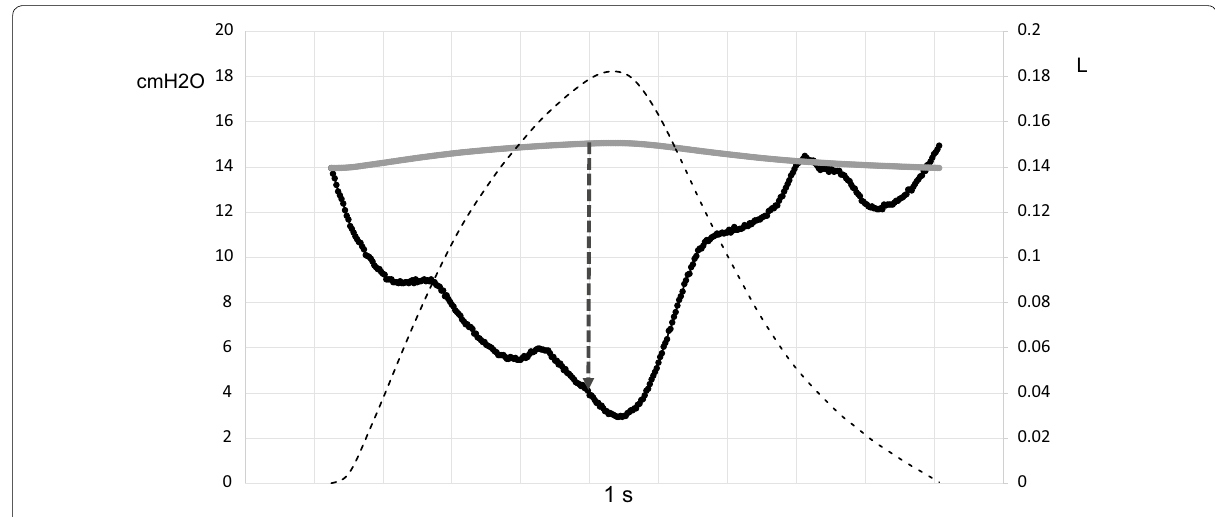
Fig. 1 Method to compute muscular pressure (Pmus) over one breath. Scope mode displays over time the tidal volume (black dashed line), the recorded esophageal pressure (Pes,dyn, black continuous line) and the computed static esophageal pressure (Pes,st gray continuous line) (record from patient #16 in the automatic tube compensation group). At any time Pmus is the distance (black dashed vertical arrow) pertaining to Pes,dyn– Pes,st. Scale in cmH 2 O in the left Y axis and in liter (l) in the right Y axis. Time scale (1 s) is